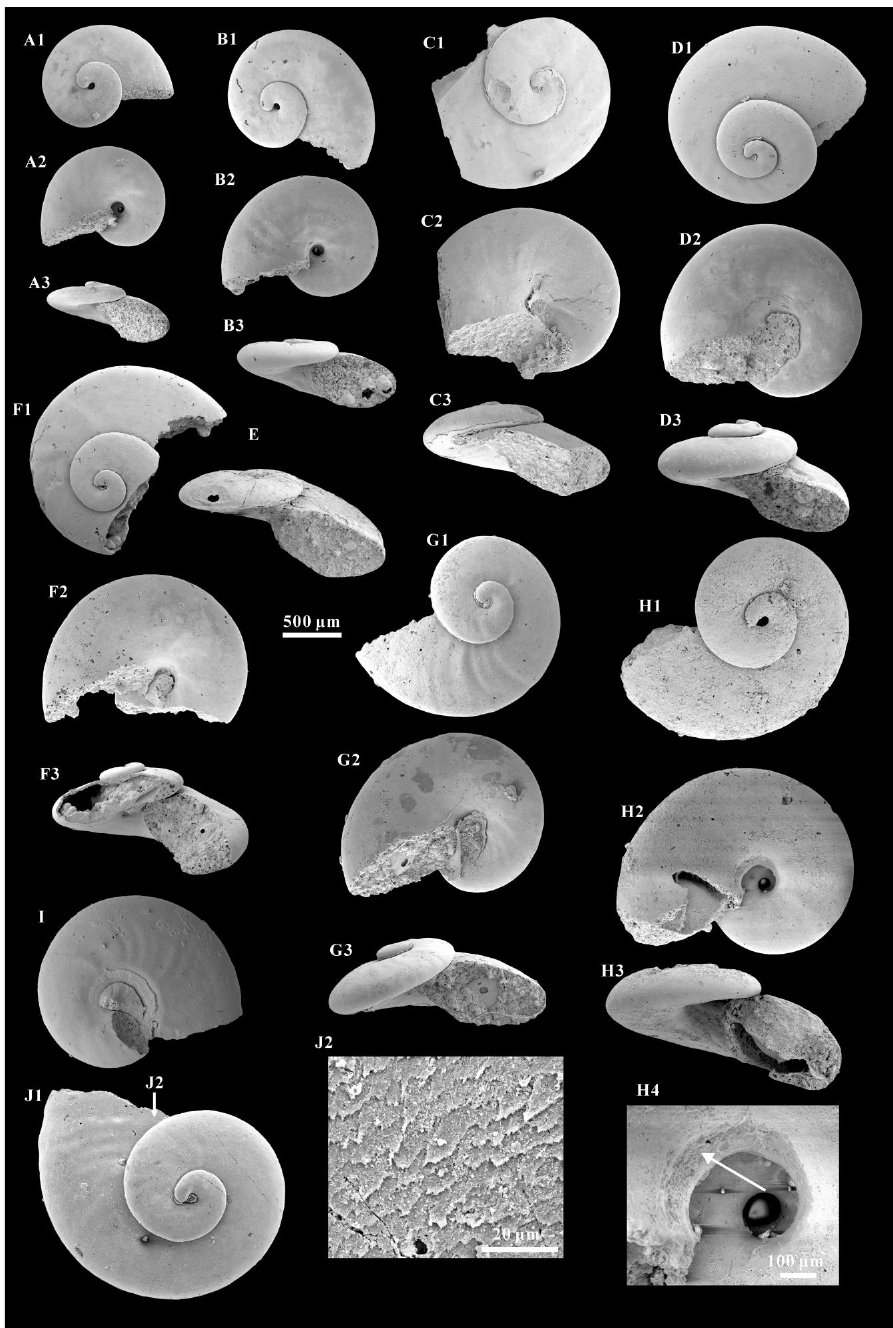
Figure 2. Different stages of Aldanella attleborensis from the Yanjiahe Formation in Yanjiahe Sec- tion. ( A ), internal molds, CUBar207-4; ( A1 ) apical view, ( A2 ) umbilical view, ( A3 ) apertural view. ( B ), internal molds, CUBar208-2; ( B1 ) apical view, ( B2 ) umbilical view, ( B3 ) apertural view. ( C ), in- ternal molds, CUBar207-11; ( C1 ) apical view, ( C2 ) apertural view, ( C3 ) umbilical view. ( D ), internal molds, CUBar206-12; ( D1 ) apical view, ( D2 ) umbilical view, ( D3 ) apertural view. ( E ), internal mold, CUBar206-3, apertural view, showing the hollow. ( F ), internal molds, CUBar207-1; ( F1 ) apical view, ( F2 ) umbilical view, ( F3 ) apertural view, showing the hollow internal mold. ( G ), internal molds, CUBar186-9; ( G1 ) apical view, ( G2 ) umbilical view, showing the well-preserved inner lip of aperture, ( G3 ) apical view. ( H ), internal molds, CUBar206-9; ( H1 ) apical view, ( H2 ) umbilical view, ( H3 ) aper- tural view, ( H4 ) magnification of ( H2 ), showing the spiral muscle scar. ( I ), internal molds, apical view, CUBar115-4. ( J ), internal molds, apical view, CUBar158-6; ( J2 ) magnification of ( J1 ), showing the laminar